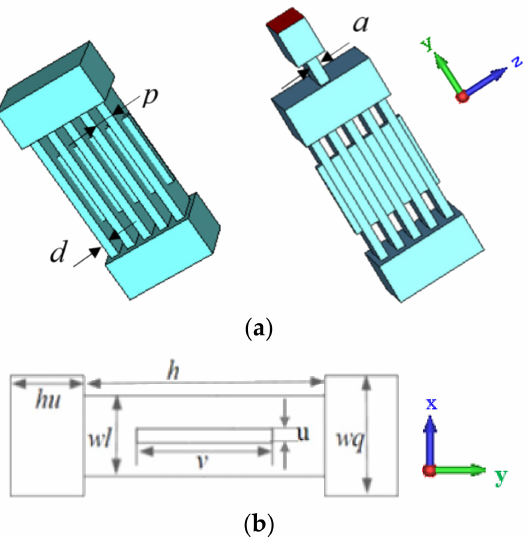
Figure 1. Schematic of the multiple gap cavity for the EIK. ( a ) A 3D model of the idler cavity and output cavity. ( b ) A cross-section in the xy plane.